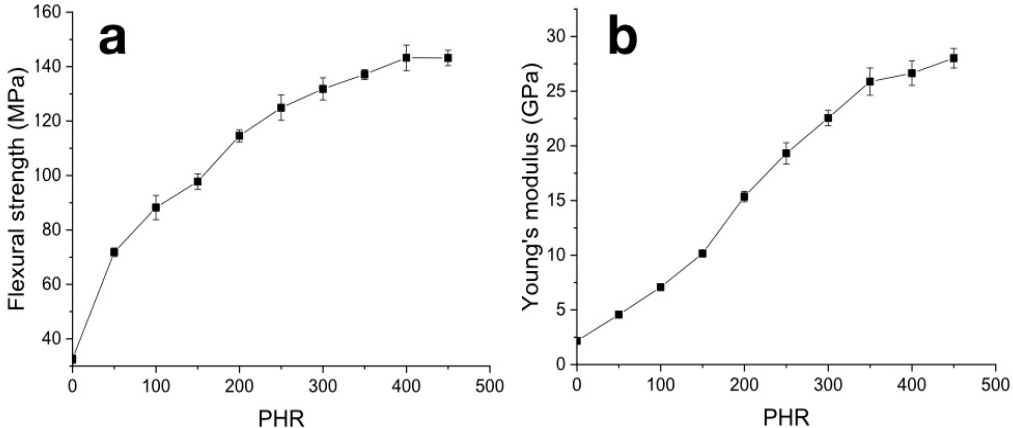
Figure 9. Concentration dependencies of strength ( a ) and Young modulus ( b ) from flexural tests of carbonized samples.